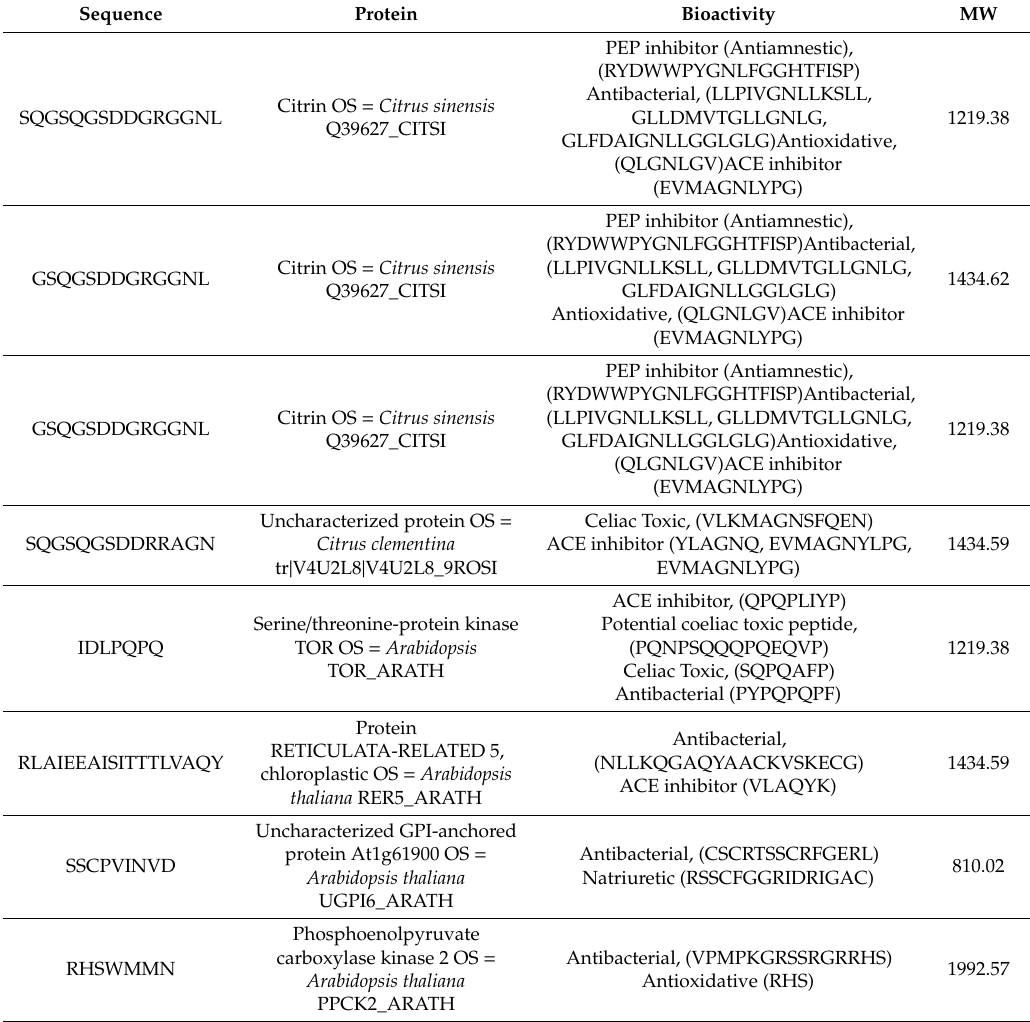
Table 3. Di ff erential peptide sequences present in F(19–20) identified from OSPH (after GI digestion), using NCBInr and UniProt